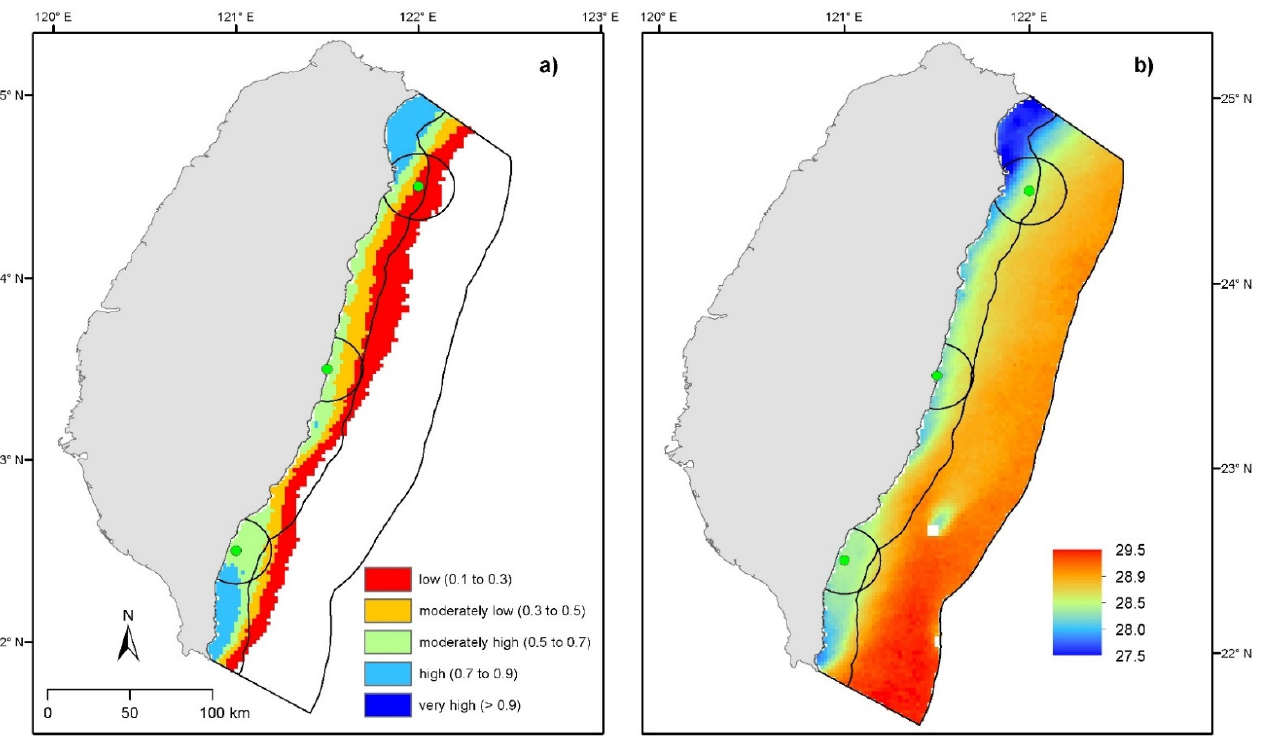
Figure 6. The overall upwelling frequency map ( a ) vs the overall temporally-averaged SST map ( b ); generated by combining the daily upwelling maps and SST maps of all upwelling dates (n = 291) together. The frequency is divided into five categories: low, moderately low, moderately high, high, and very high.